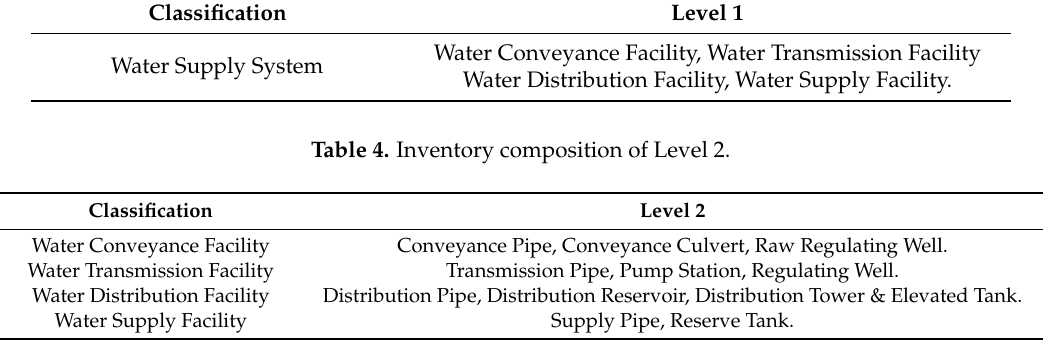
Table 5. Inventory composition of Level 3.